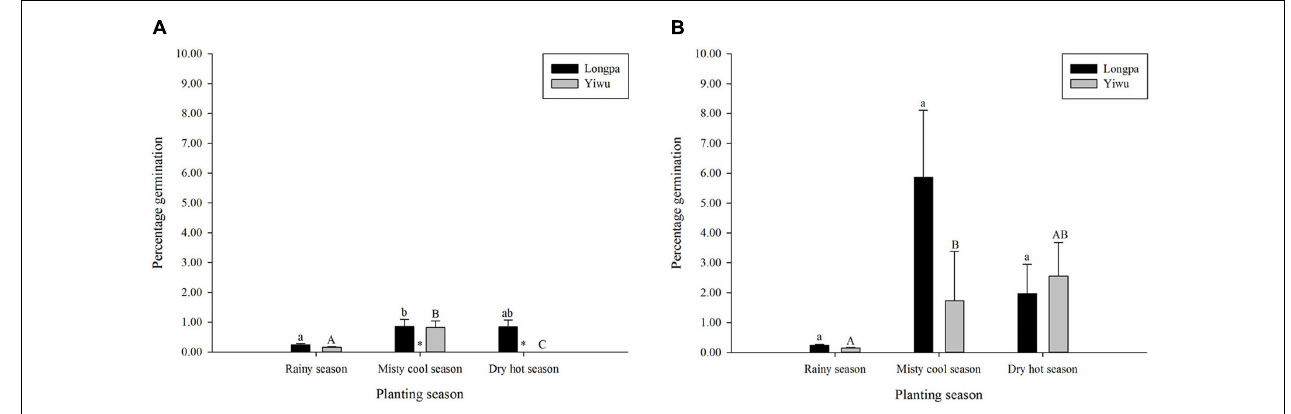
FIGURE 3 | The effect of sowing season on in situ symbiotic seed germination for D. devonianum at two locations by (A) Plastic Wrap and (B) Plastic Wrap + packet treatments. Letters indicate significant differences among seasons and astericies show significant differences among Longpa and Yiwu sites in Yunnan, China. TABLE 3 | Pairwise comparison of the effect of three sowing seasons on seed germination in D. devonianum for Plastic Wrap and Plastic Wrap + packet treatments at the Longpa and Yiwu sites, Yunnan, China.